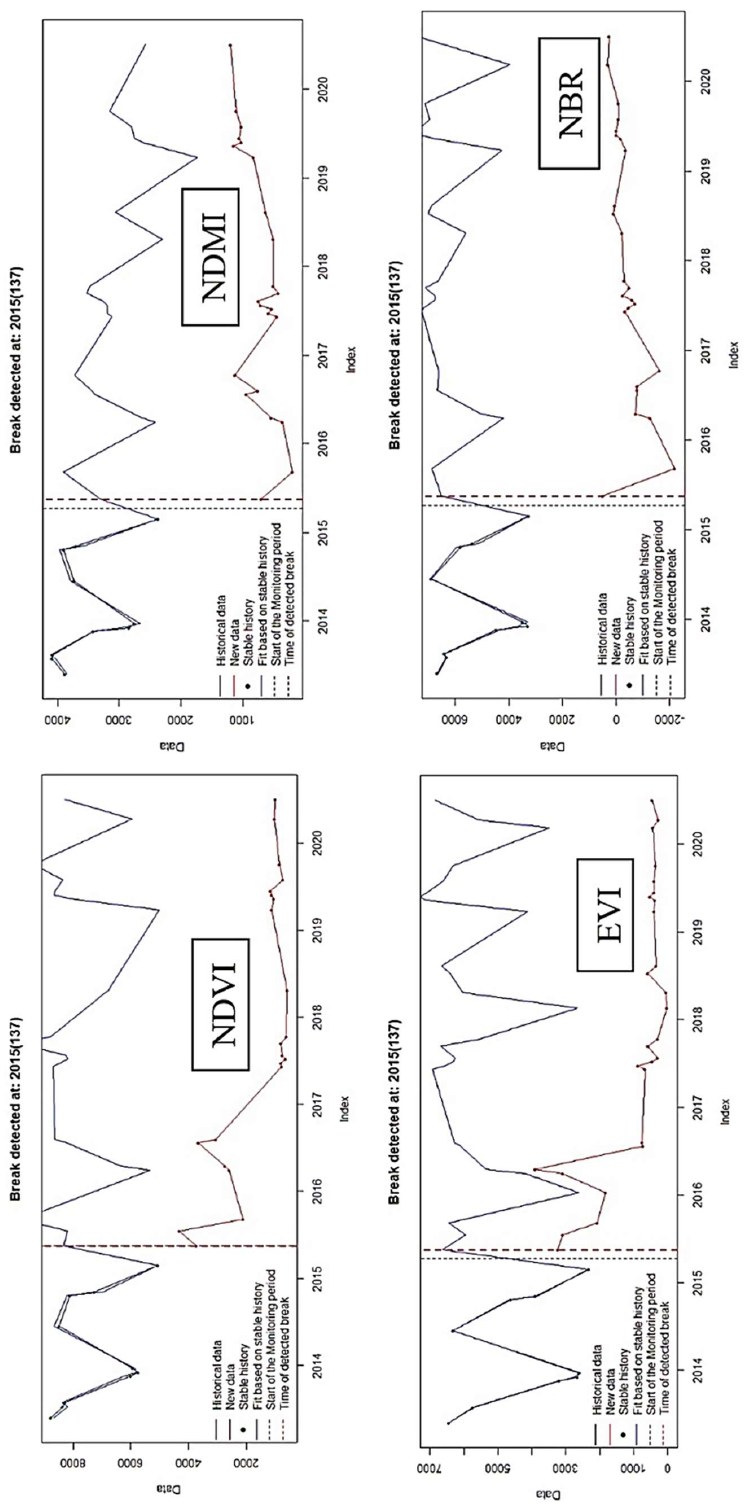
Figure 5. NDVI, NDMI, EVI, and NBR time series profiles using pixel-level analysis of the BFAST- Monitor algorithm over study area A.